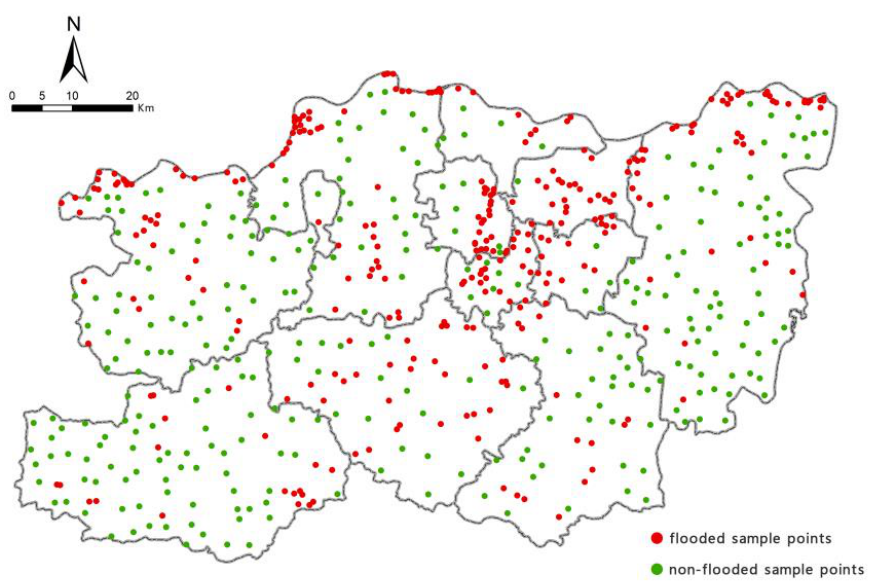
Figure 3. Distribution of sample points.